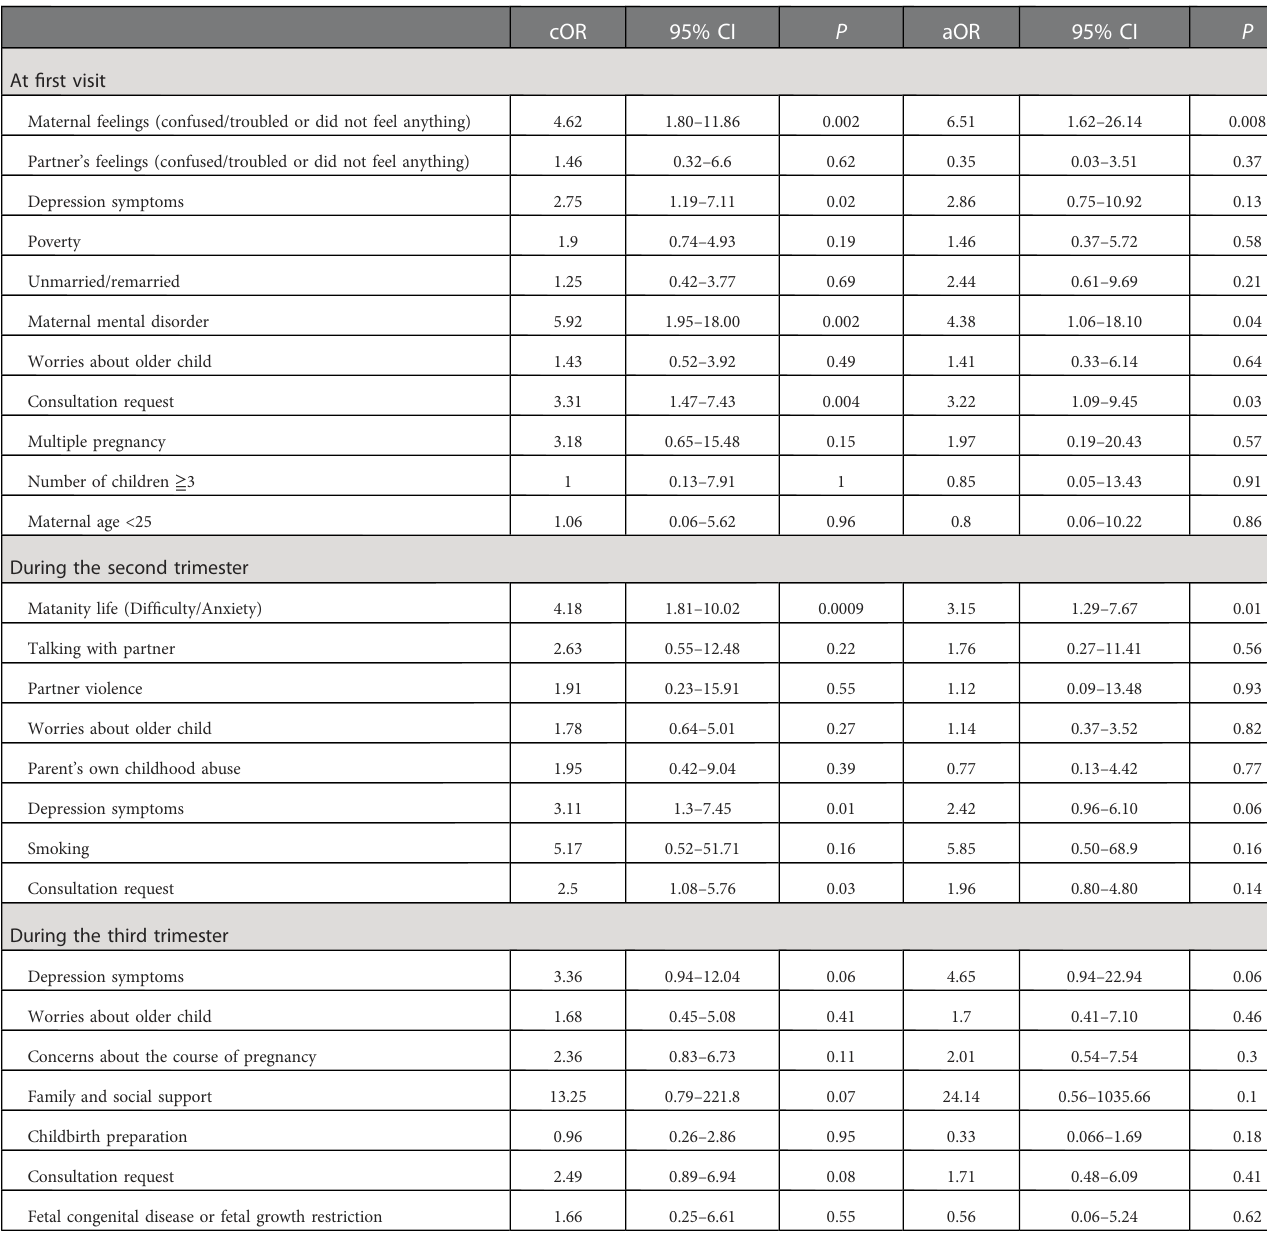
TABLE 6 Relationship between EPDS ≧ 9 and each item on the NEW interview